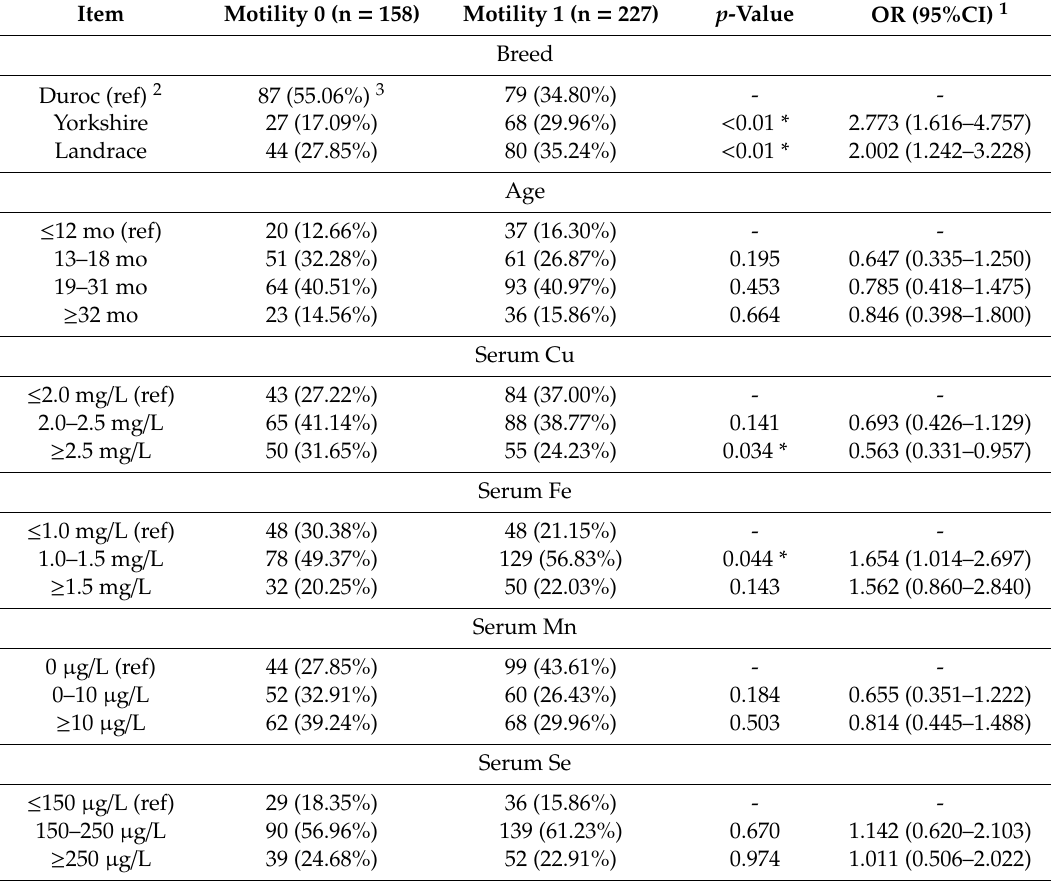
Table 3. The potential influencing factors and univariate analysis results of the sperm motility (n =